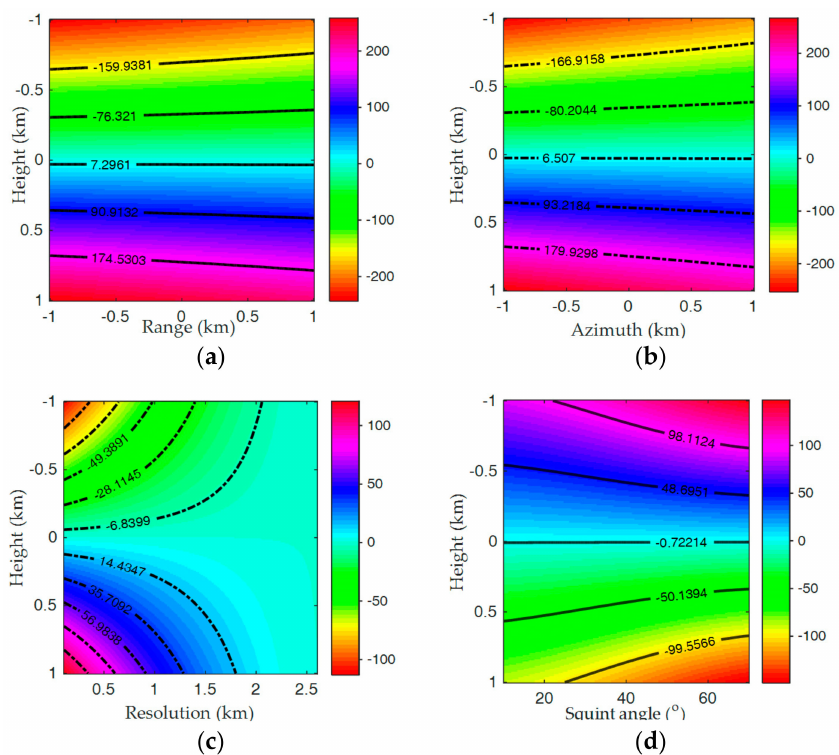
Figure 2. Quadratic phase errors (QPEs) introduced by topography variations in different domains: ( a ) QPEs introduced by topography variations in range/height domain; ( b ) QPEs introduced by topography variations in azimuth/height domain; ( c ) QPEs introduced by topography variations in the resolution/height domain; ( d ) QPEs introduced by topography variations in the squint angle/height domain.